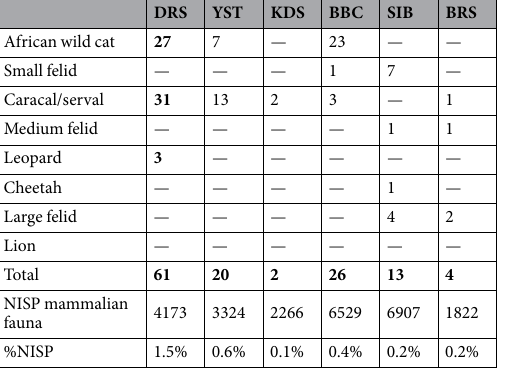
Table 4. Felid remains recovered from other MSA sites in southern Africa. The observations, provided in NISP and % of the total NISP for the mammalian assemblages, come from: 63 for Ysterfontein (YST); 37 for Klipdrift Shelter (KDS); 36,60,61 for Blombos Cave (BBC); 62 and 38 for Sibudu Cave (SIB); and 64 for Bushman Rock Shelter